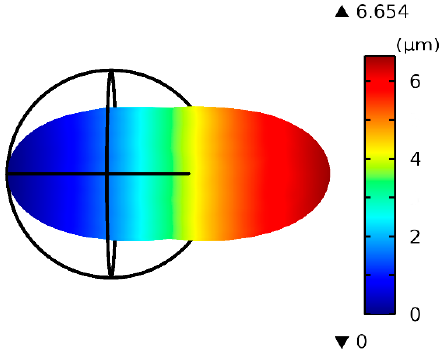
Figure 3. The deformation of a cell with (cid:1853) (cid:2868) = 6 μ m under 16 V AC. The color represents the displacement along the x axis.